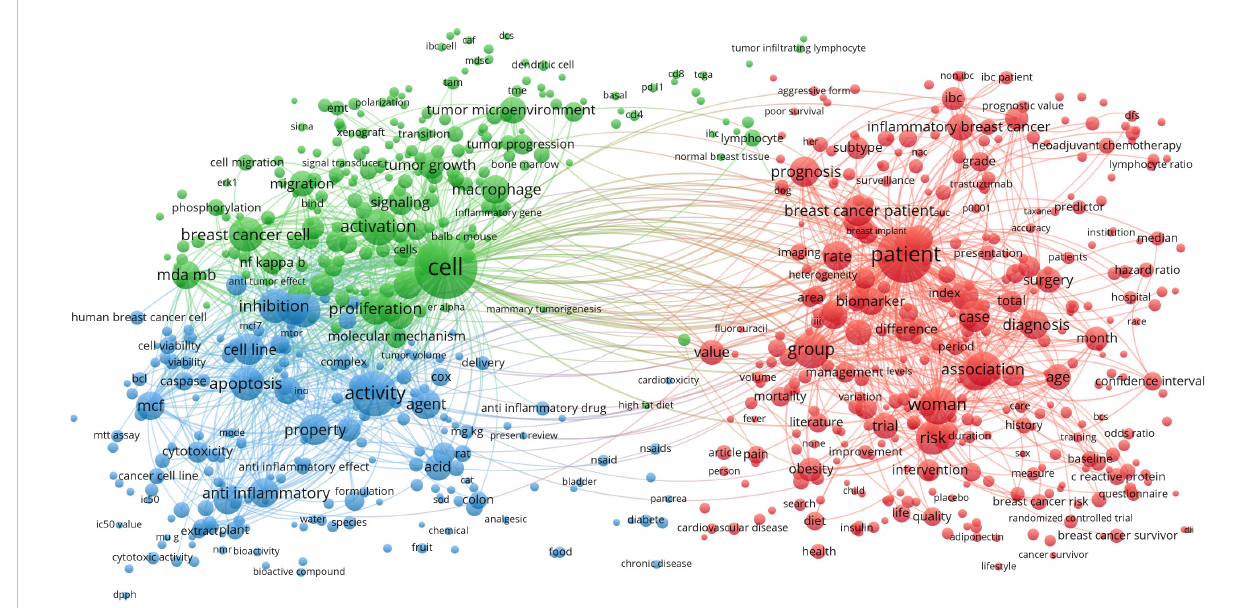
FIGURE 7 Analyzing the role of in fl ammation in breast cancer research using a co-word network and clustering of relevant keywords. Co-word frequency is represented by node size, co-word intensity by connection thickness, co-word network clustering results by color, and a tighter association between two words is shown by a node ’ s proximity to another node of the same